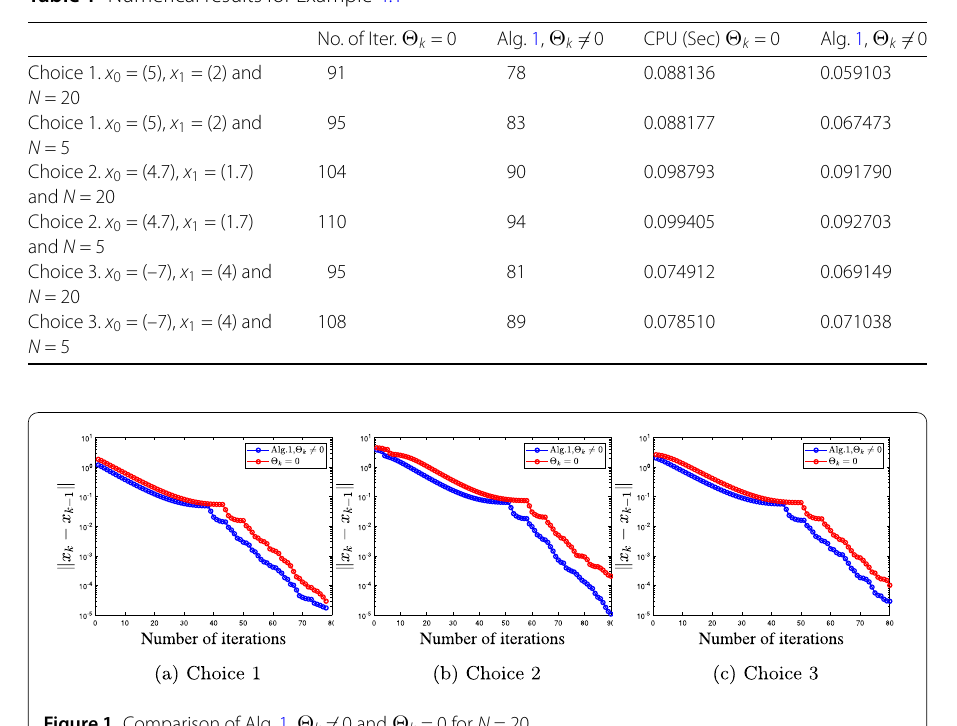
Figure 1 Comparison of Alg. 1, (cid:8) k (cid:9) = 0 and (cid:8) k = 0 for N = 20